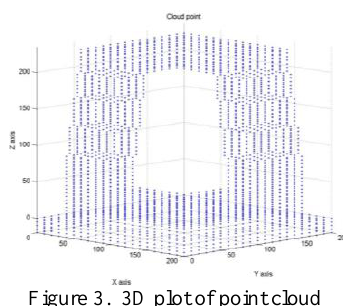
Figure 3. 3D plot of point